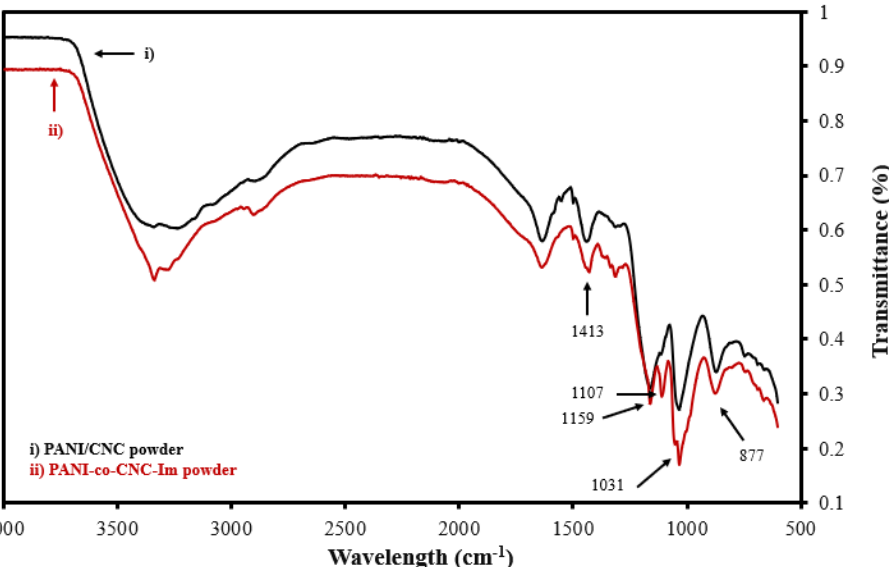
Figure 3. Overlaid FTIR spectra for isolated (i) PANI/CNC and (ii) PANI-co-CNC-Im polymer powders.